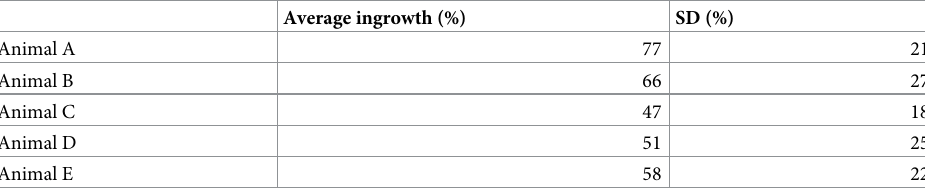
Table 1. Ingrowth (%) data for the individual